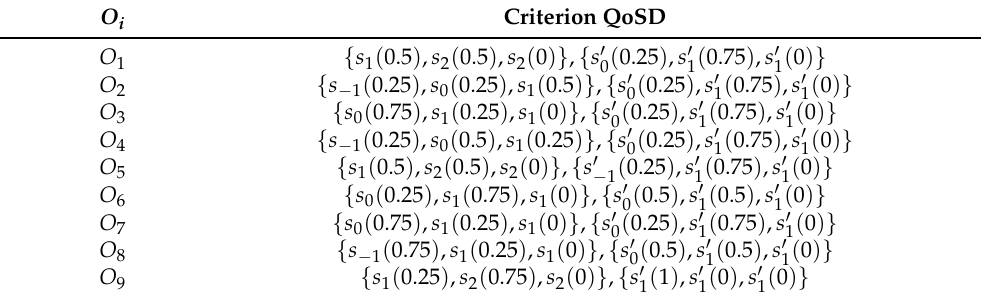
Table 11. Normalized qualitative matrix for criterion QoSD.